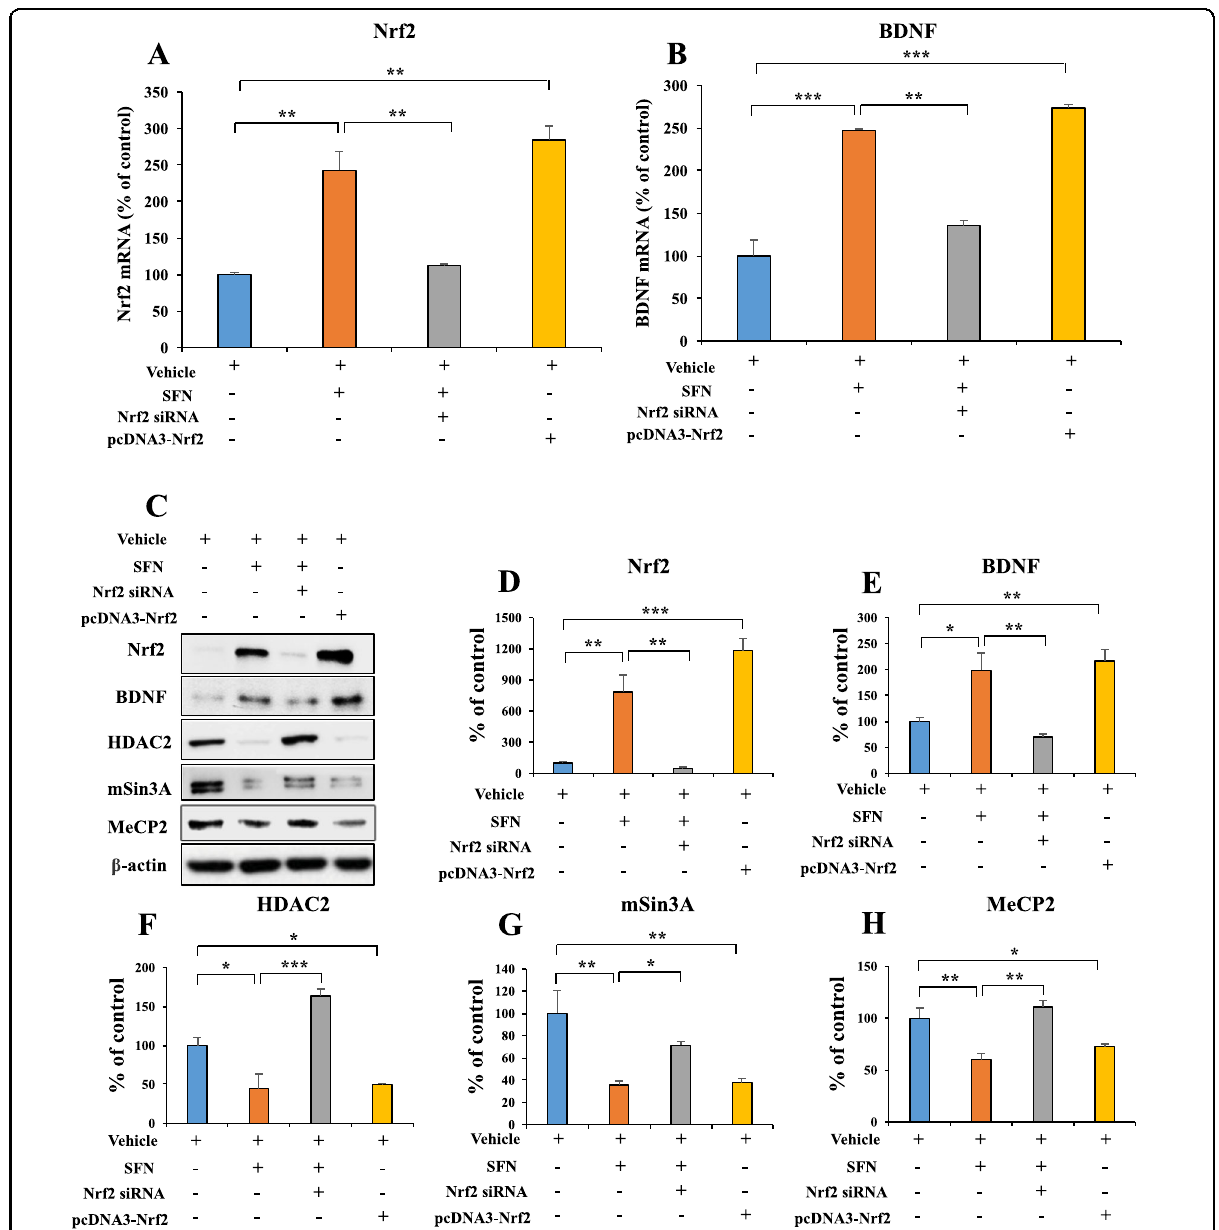
Fig. 1 Activation of Nrf2 inhibits BDNF transcriptional repressor (MeCP2, HDAC2, and mSin3a) expression in Neuro-2a cell. A , B The quantitative real-time PCR for Nrf2 and Bdnf (mean± SEM, n = 3 per group, one-way ANOVA, ** p < 0.01 and *** p < 0.01). C The representative image for western blot. D The quantitative result for Nrf2. E The quantitative result for BDNF. F The quantitative result for HDAC2. G The quantitative result for mSin3A. H The quantitative result for MeCP2 (mean ± SEM, n = 3 per group, one-way ANOVA, * p < 0.05, ** p < 0.01, and *** p <